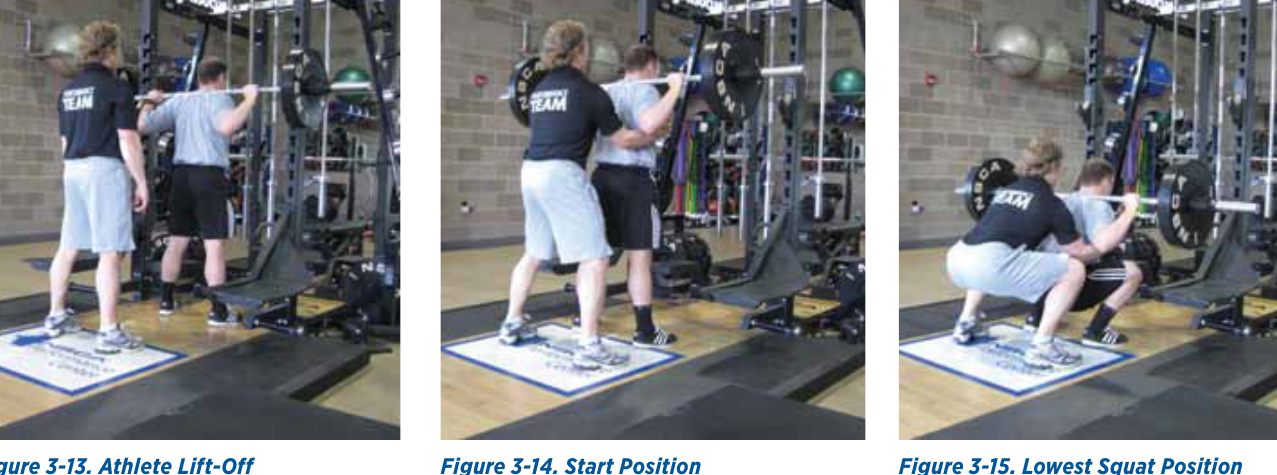
Figure 3-13. Athlete Lift-Off Figure 3-15. Lowest Squat Position Figure 3-14. Start Position